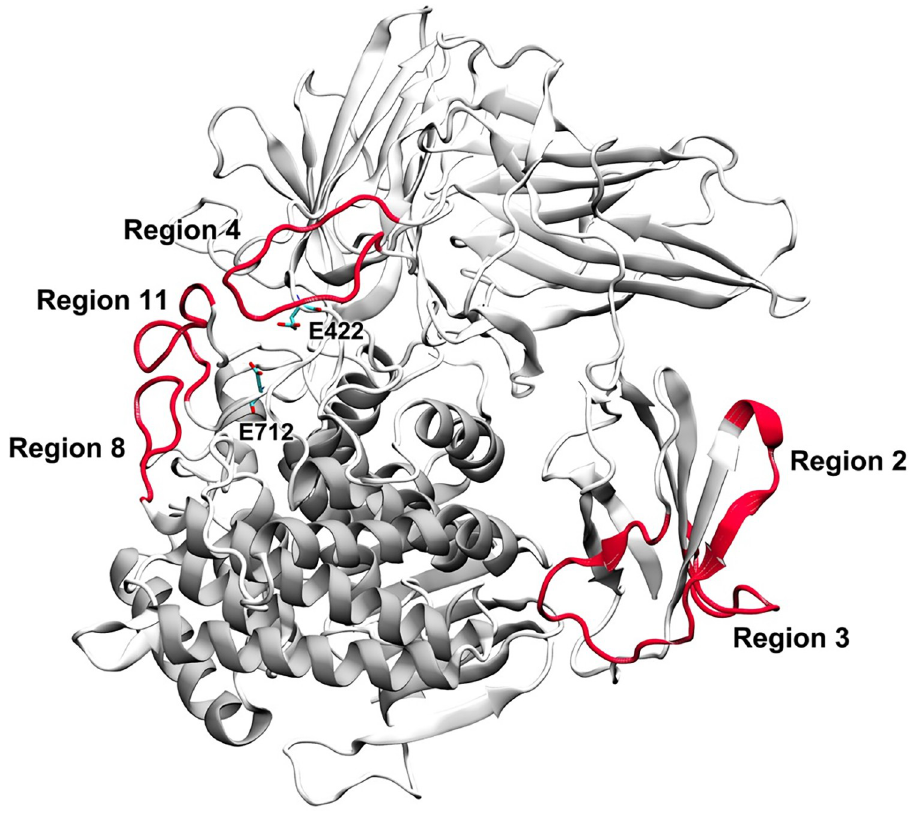
Fig 3. The centroid structure of Model A shows five highly flexible regions (region 2, 3, 4, 8 and 11) with the highest average RMSF value as shown in red secondary structure.